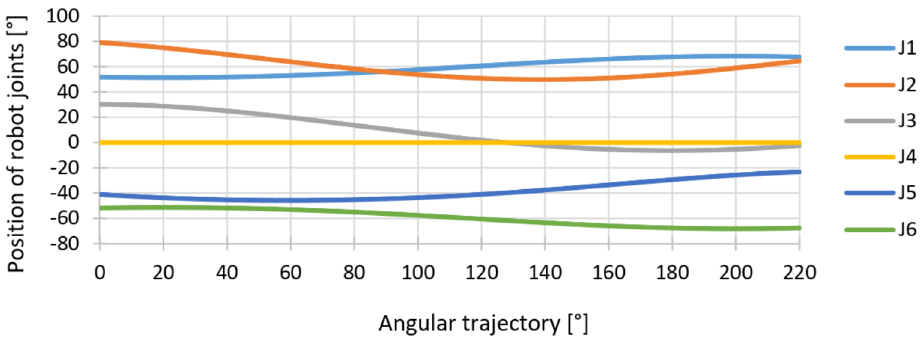
Figure 5. The course of the motion of the individual robot joints during the TCP movement in a circular path in the ZX